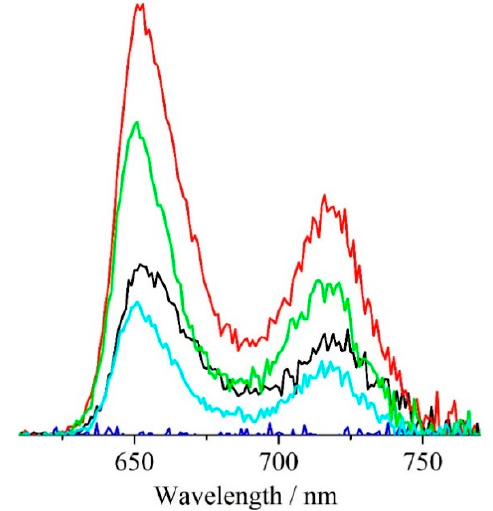
Figure 10. Fluorescence spectra ( λ ex = 410 nm) of the Au NPs–porphyrin systems centrifuged and deposited on quartz substrates. Starting Au NPs (blue line), centrifuged solutions upon the addition of 240 (black line), 450 (red line), 700 (green line), and 900 (cyan line) µL aliquots of a 2.07 × 10 − 5 M porphyrin CH 3 OH solution (final total volume of the solution 3 mL).